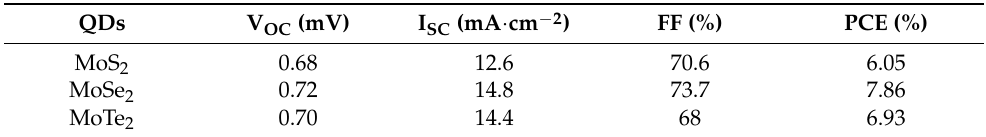
Table 4. Photovoltaic parameters of the QDSSCs with the use of the MoX 2 nanoparticles as the